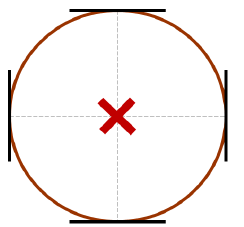
Figure 5. The schematic representation of the position of targets on the perimeter of a